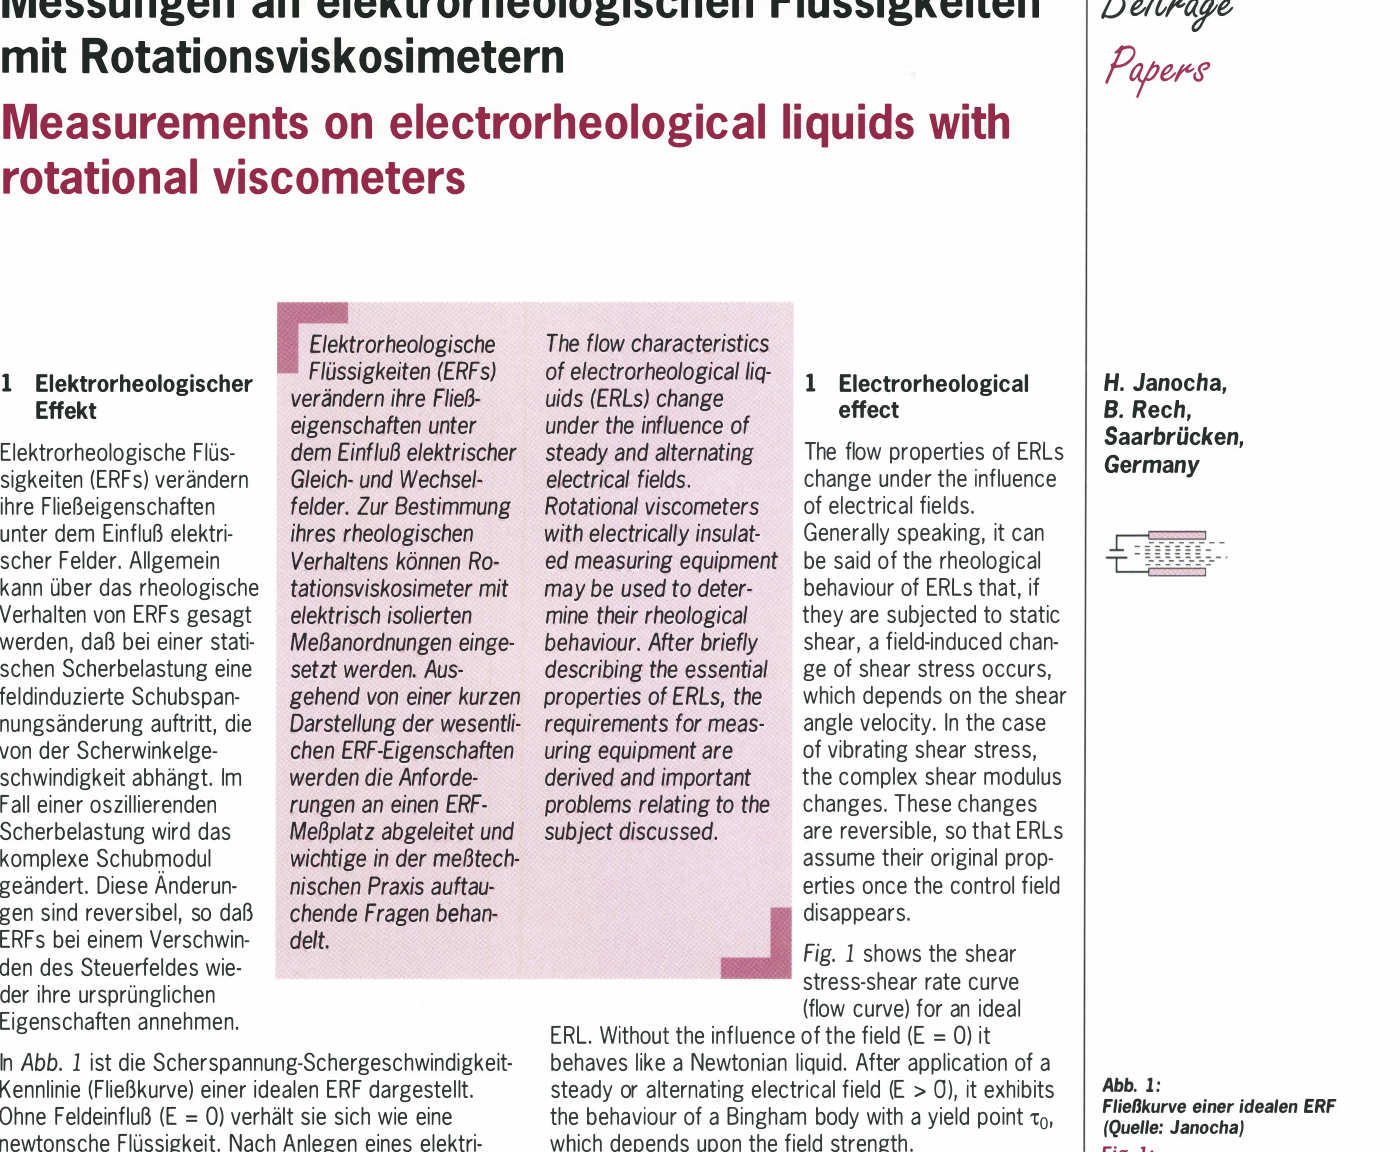
Fig. I: Flow curve for an ideal ERL (source: